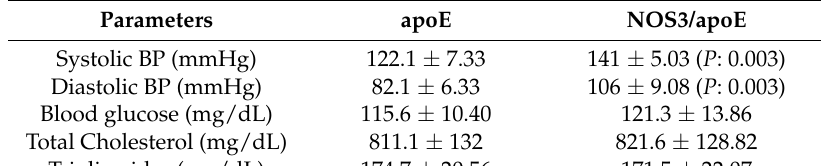
Table 1. Fasting blood glucose, lipid content and blood pressure.